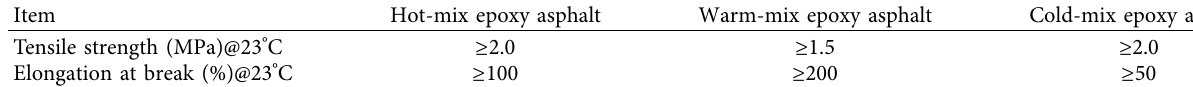
Table 7: Technical requirements of epoxy asphalt in JTG/T3364-02.